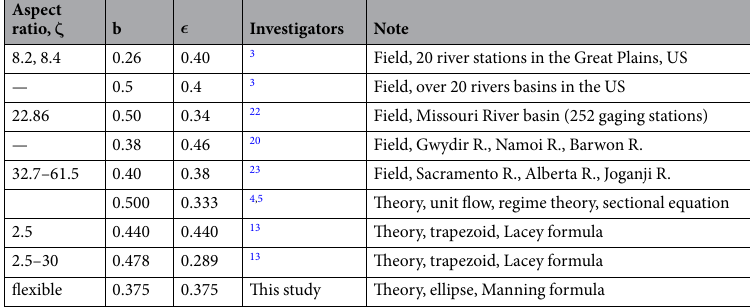
Table 2. Estimated parameters for the regime formulas from the selected